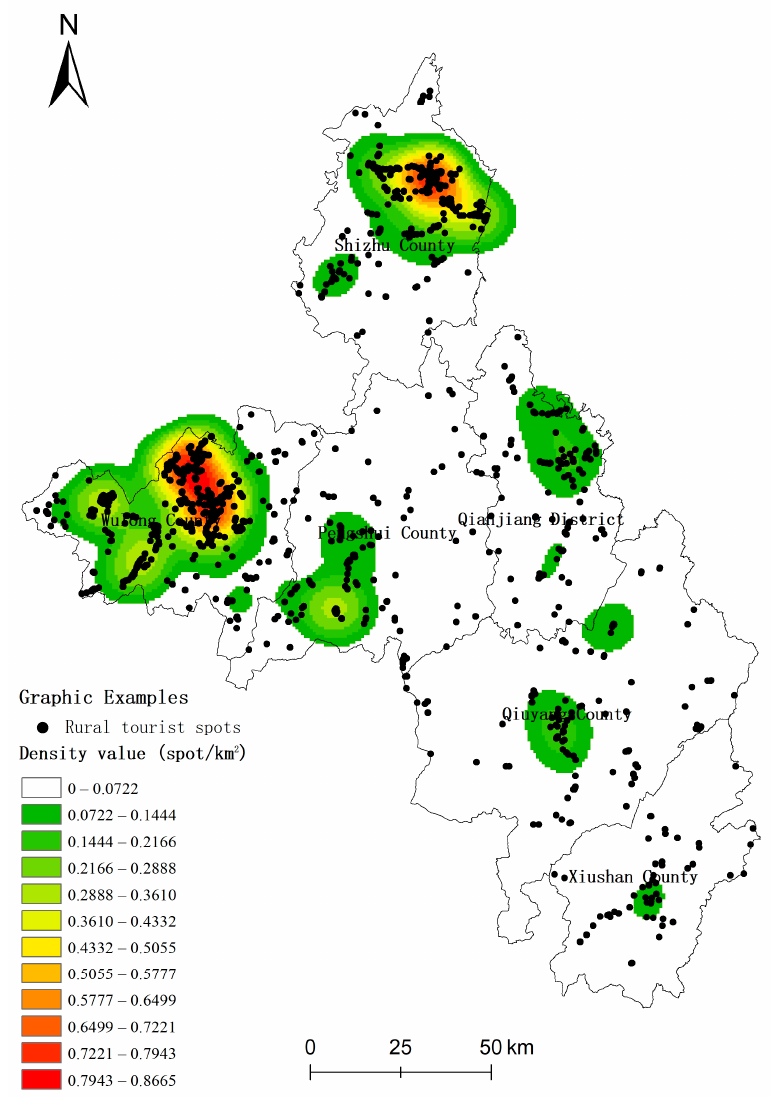
Figure 2. Kernel density estimation of rural tourism.